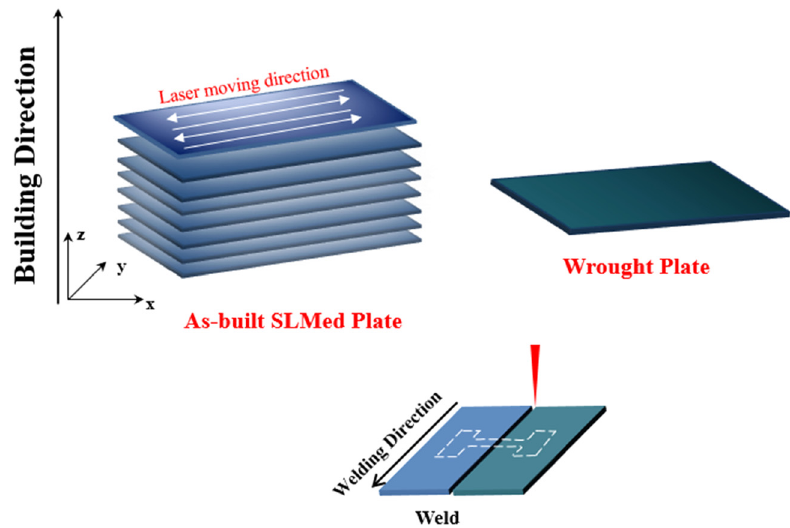
Figure 1: Schematic diagram of laser - welded joints ’ preparation and the tensile